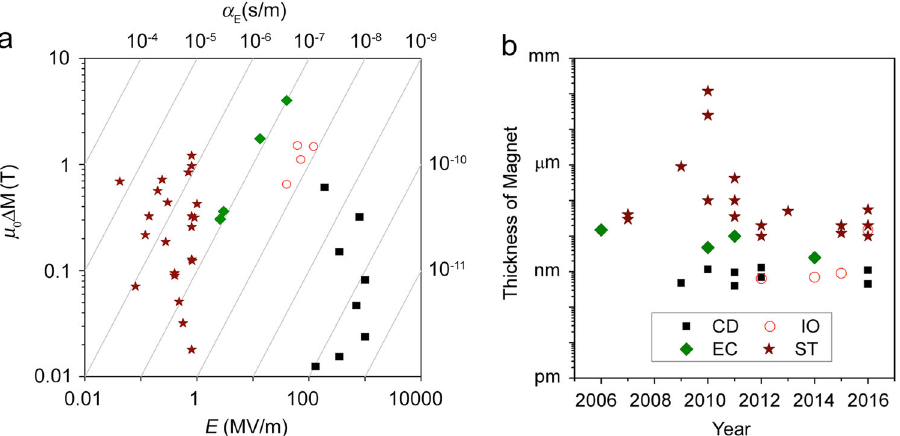
Fig. 9 Some experimental reports of converse magnetoelectric coupling in magnetoelectric heterostructures, sorted by a plotting the electrically induced change of magnetization ( μ 0 Δ M ) as a function of applied electric fi eld ( E ), and b the thickness of the constituting magnetic layer in a chronological order. The gray lines in a indicate different levels of α E ( = μ 0 Δ M/E ). CD Charge Densities, IO Interfacial Oxidation, EC Exchange Coupling, ST Strain Transfer. See Tables 1a – d for